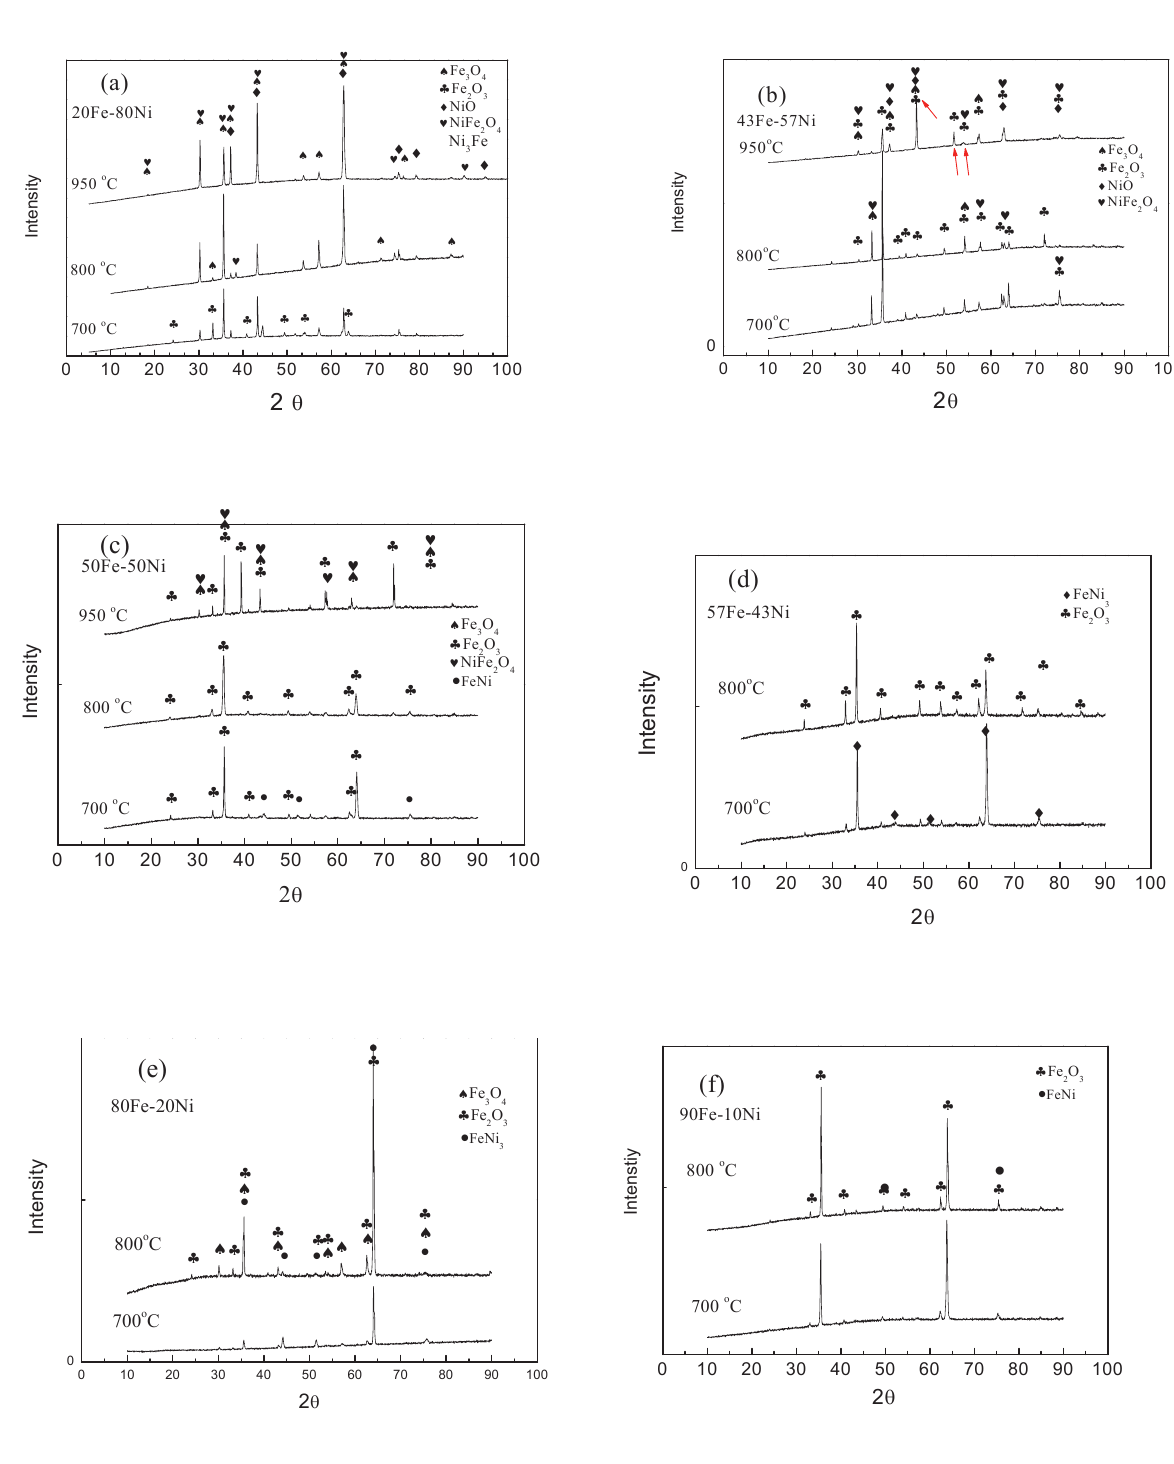
Figure 2. XRD patterns of oxidation surface of Fe-Ni